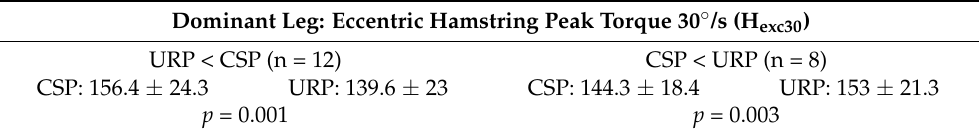
Table 2. Comparison of means of the subjects reporting lower values of eccentric hamstring PT